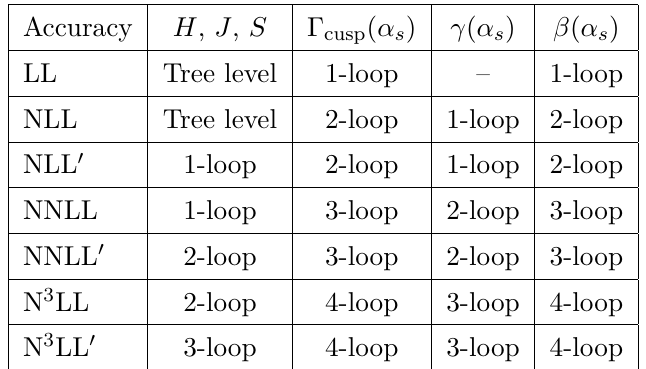
Table 1 . Classification of the resummation accuracy in terms of the fixed-order expansions of boundary term, anomalous dimensions and beta